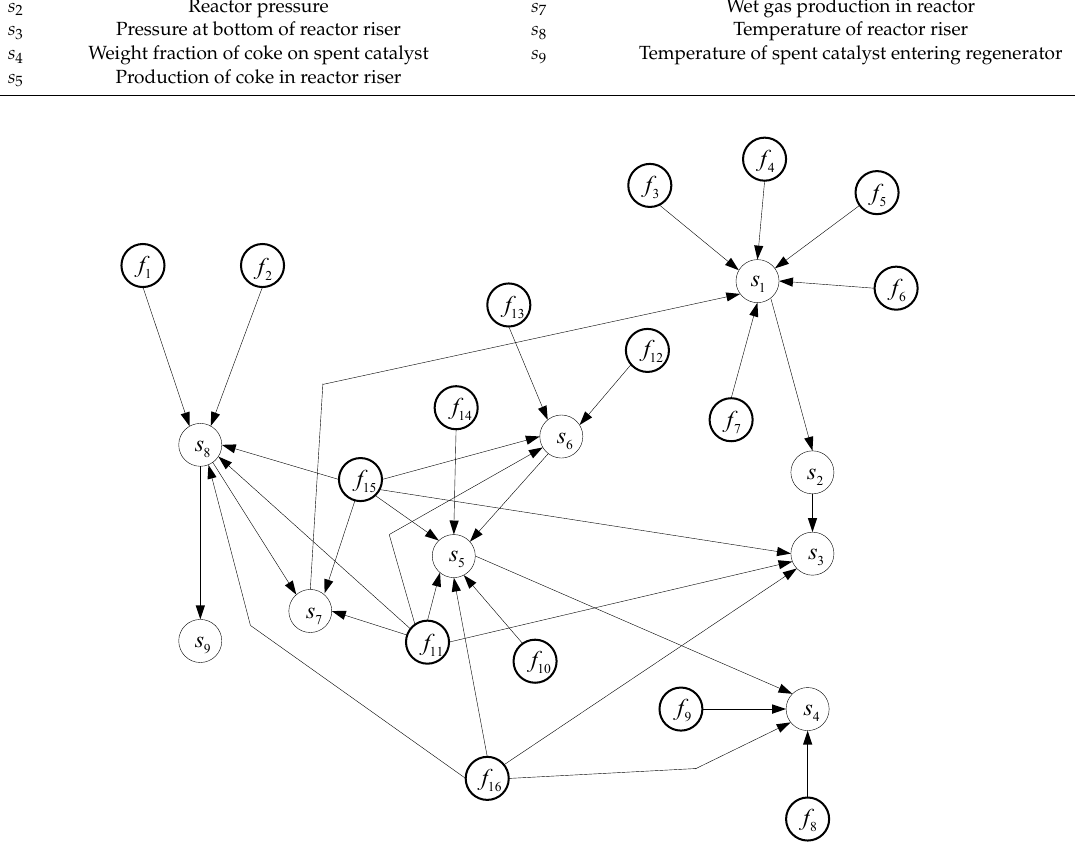
Figure 4. The directed graph of a FCCU.